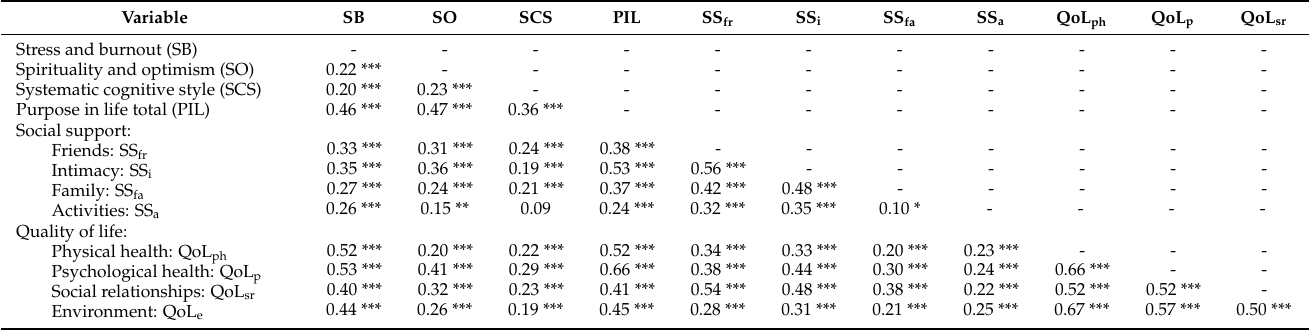
Table 5. Pearson’s correlation coefficients between studied variables